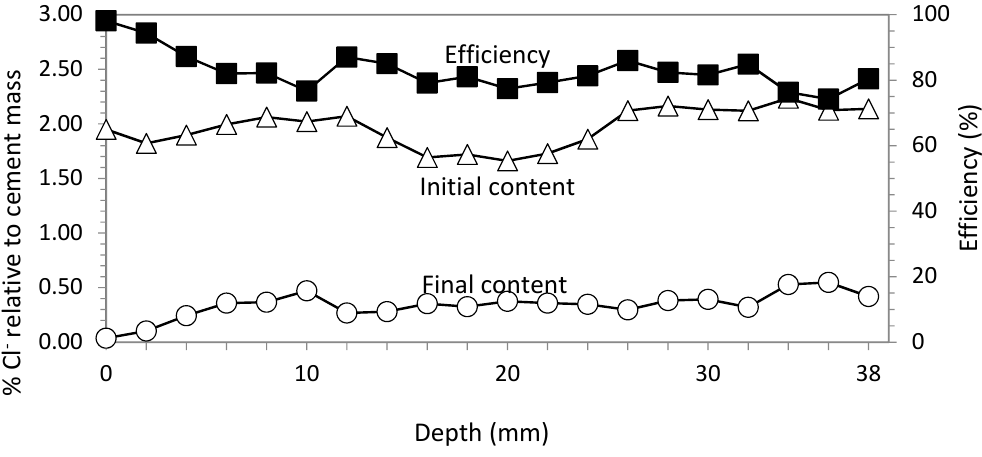
Figure 5. Study 1. Circular section specimen. ECE with Ti-RuO 2 mesh anodic system. Current density 5 A/m 2 . Current charge density 5 × 10 6 C/m 2 . Contents of Cl −